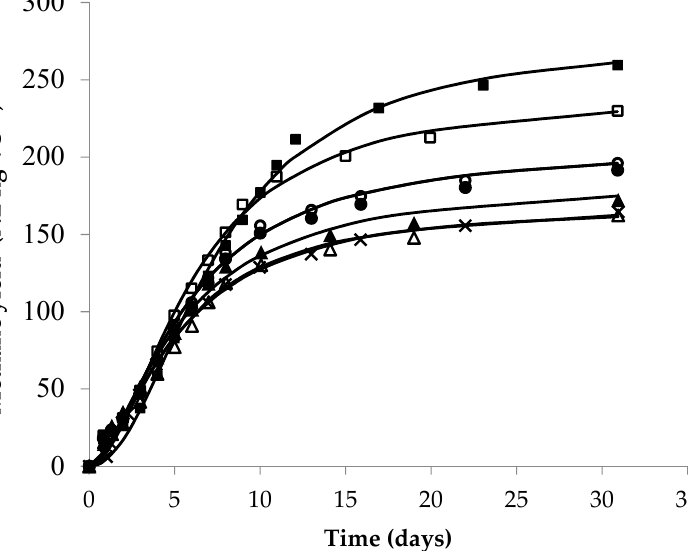
Figure 5. Cumulative methane production for untreated and pretreated rice processing residue.